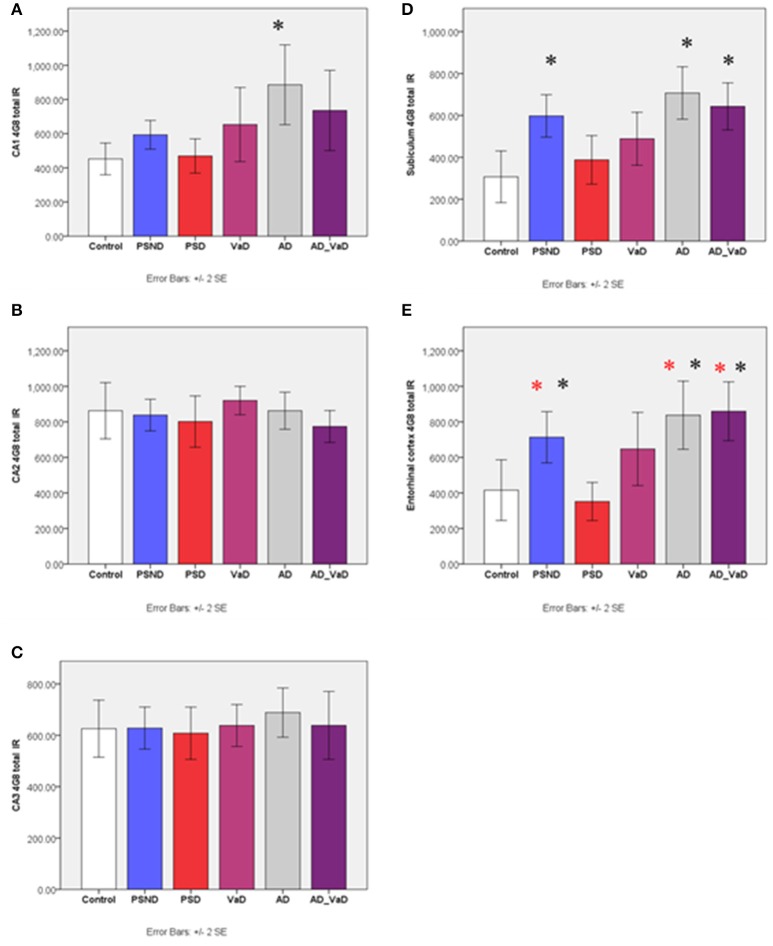
Bar graphs showing the distribution of total Aβ IR across hippocampal sub-regions (A) CA1, (B) CA2, (C) CA3, (D) Subiculum, (E) Entorhinal cortex in Controls, PSND, PSD, VaD, AD and AD_VaD. Bars show ± 2 SEM *Mann Whitney U-test was used to compare means of each group. *p < 0.05; + p < 0.1 (in comparison with the control group). *(red) showed significant difference from PSD group. IR (immunoreactivity).